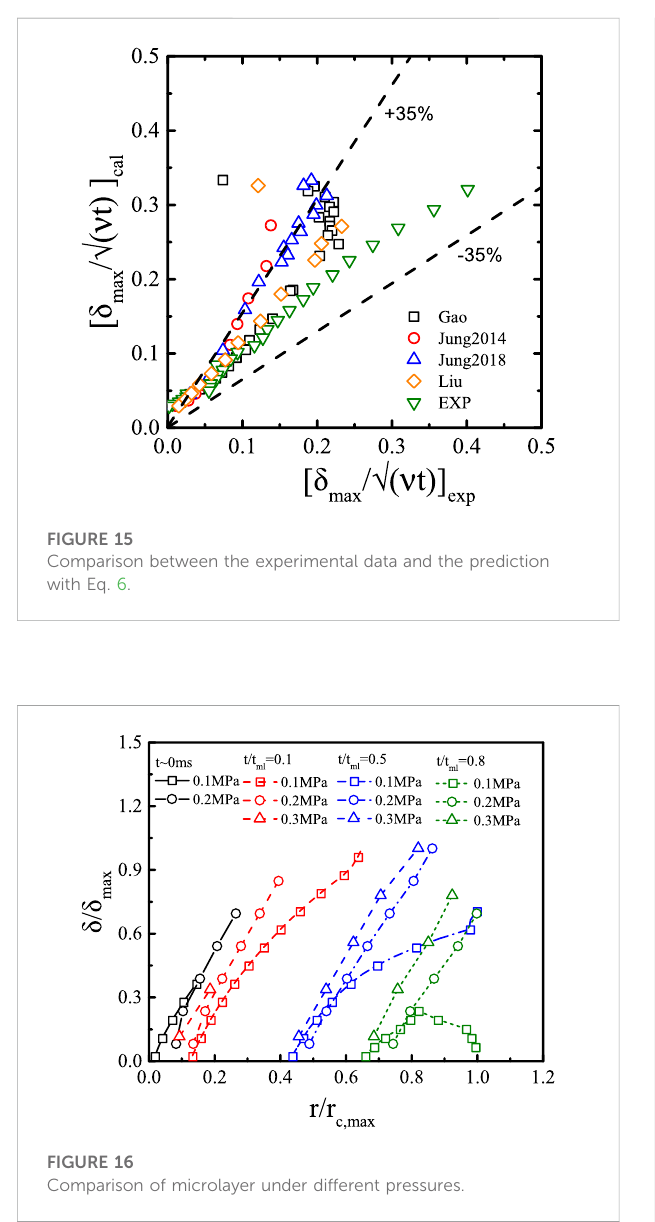
FIGURE 16 Comparison of microlayer under different pressures.